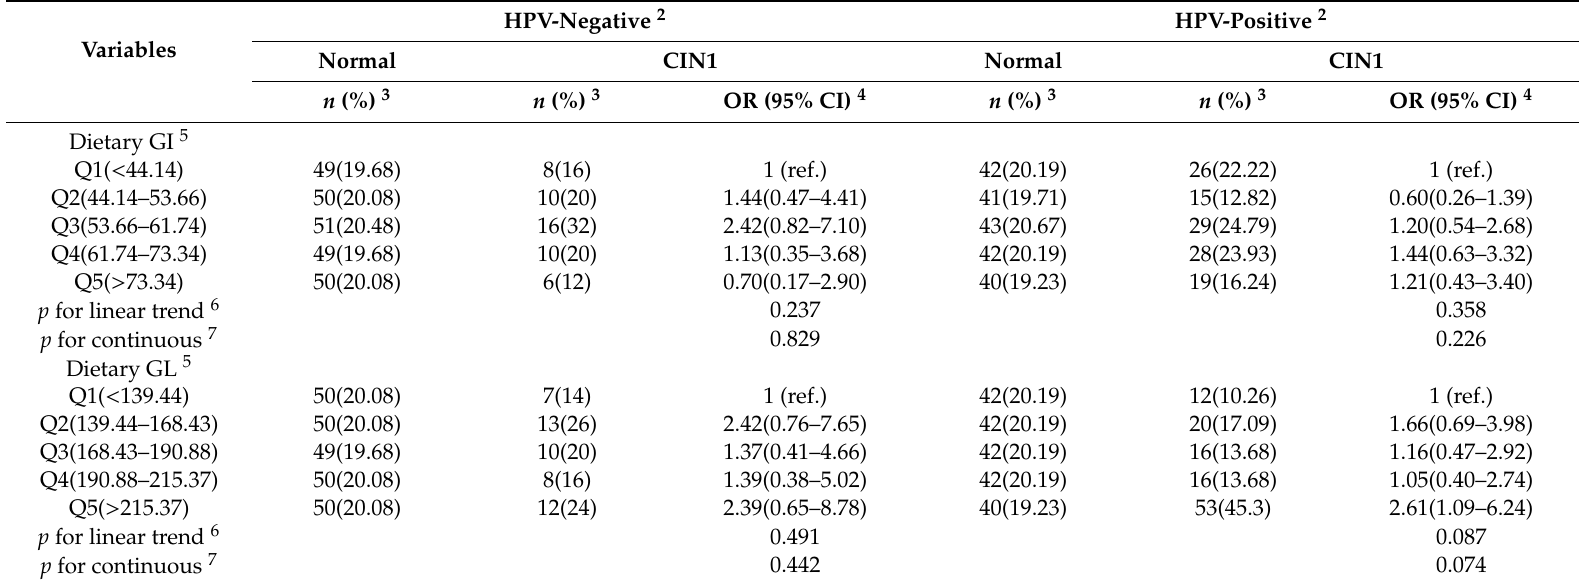
Table 5. Multivariate ORs of dietary GI and GL for CINs and cervical cancer risk with subjects stratified into HPV-negative and positive groups 1